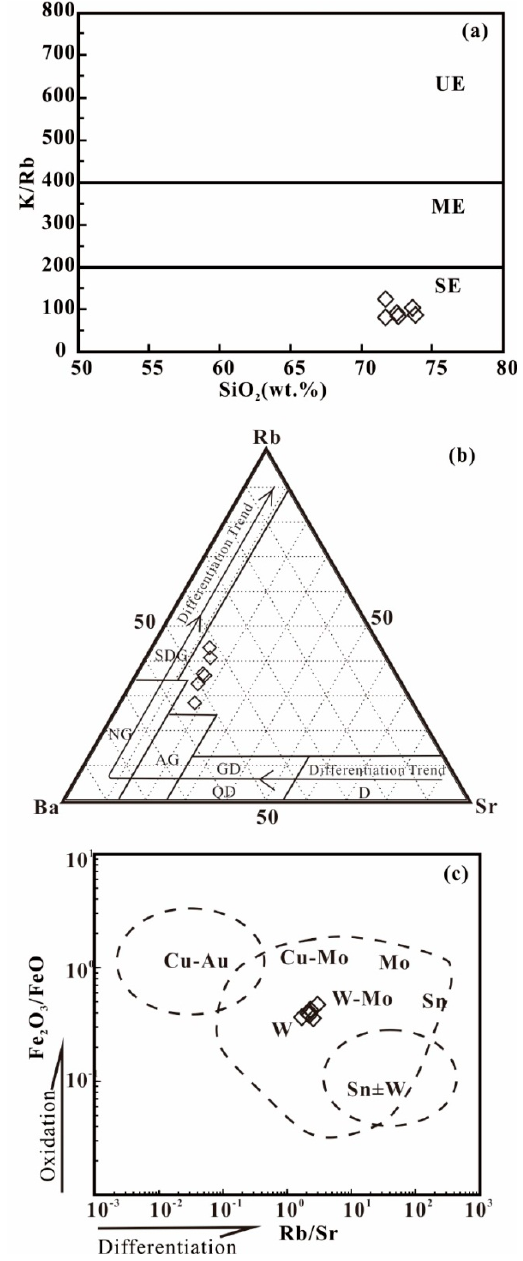
Figure 13. K/Rb vs. SiO 2 ( a after [44]), Rb-Ba-Sr ternary diagram ( b after [49]), and Fe 2 O 3 /FeO vs. Rb/Sr ( c after [45,50]) diagrams for the MG from Wulandele Mo deposit. UE—Unevolved, ME—Moderately evolved, SE—Strongly evolved; D—Diorites, QD—Quartz Diorites, GD—Granodiorites, NG—Normal Granites, SDG—Strongly Differentiated Granites, AG—Anomalous Granites.